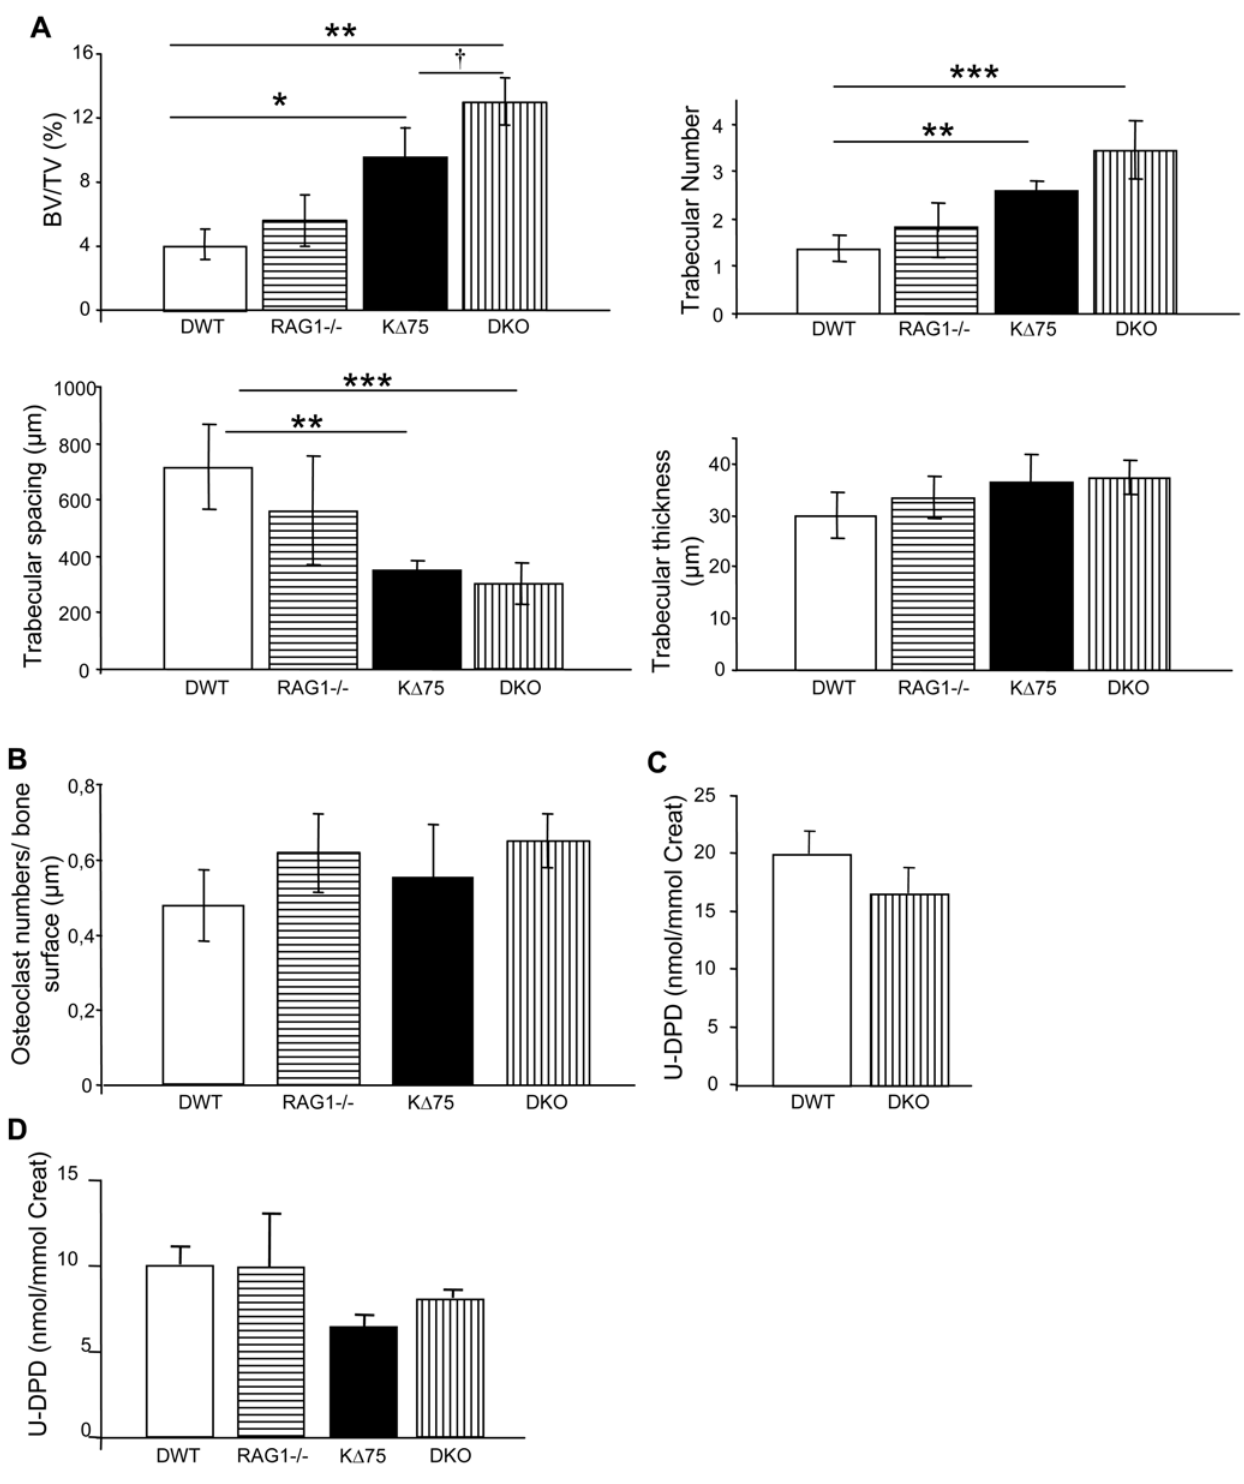
Figure 4. Absence of mature lymphocytes invivo enhances the osteopetrosis phenotype in K D 75 mice through inhibition of osteoclast function. K D 75 mice were crossbred with Rag1-/- mice devoid of mature lymphocytes. The bone phenotype of K D 75;Rag1-/- mice (called DKO), as well as control littermates (DWT, Rag1-/- and K D 75 mice), was quantified by histomorphometric analysis. (A) Bone mass was assessed after Von Kossa/ Von Gieson staining; trabeculae numbers, thickness and space between trabeculae were quantified using specific softwares. K D 75 mice have a mild but significant osteopetrosis compared with DWT mice. Rag1-/- mice did not exhibit any bone phenotype whereas osteopetrosis in K D 75 mice increased in the absence of lymphocytes (DKO mice) and was statistically significant, compared to DWT or K D 75 mice. (B) TRAP + osteoclast numbers per bone surface unit were assessed directly on bone slices. No statistical differences were observed between animals of the four different genotypes. (D and E) Deoxypyridinoline cross-link degradation products were measured in evening urines and expressed as a ratio with creatinine in 3-month- old females (C) and 6-month-old males (D). (*or { p , 0.01, ** p , 0.001, *** p , 0.0001) doi:10.1371/journal.pone.0000585.g004 PLoS ONE |